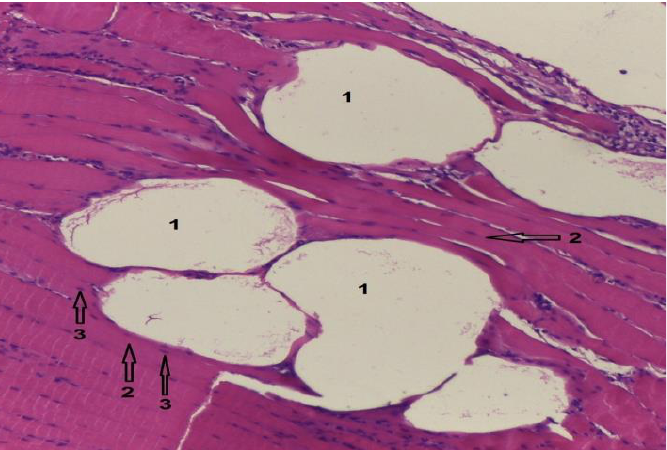
Figure 24. Muscle tissue, Hematoxylin – Eosin stain; 10 × 10 magnitude. 1-Hydrogen bubbles, 2- Normal muscle fibers, 3-Normal aspect of the nuclei.